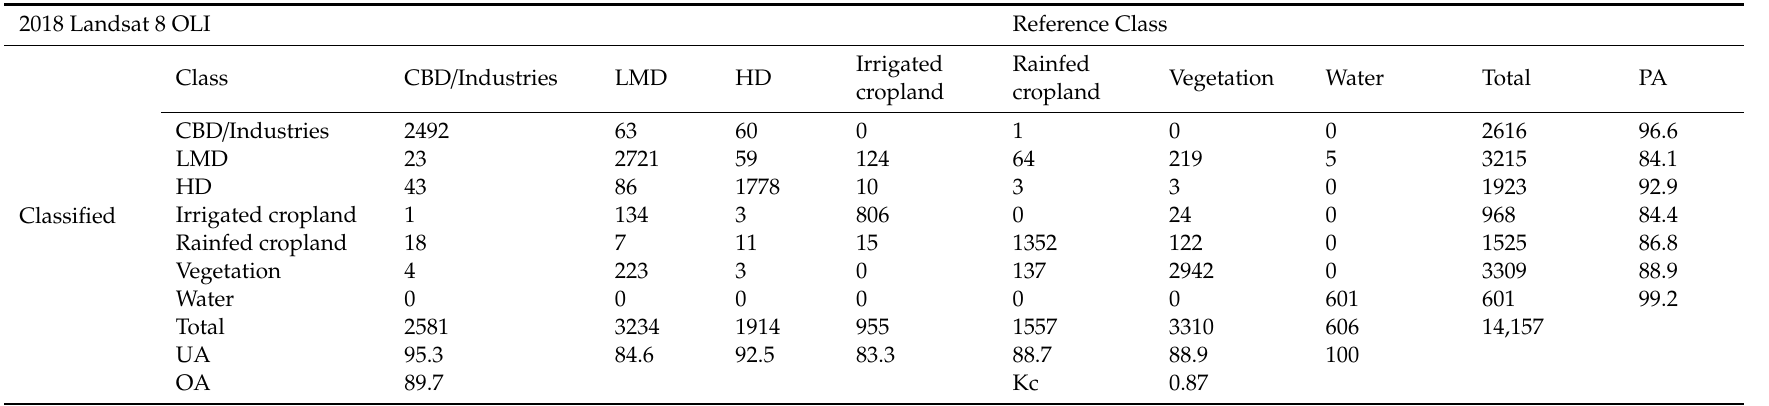
Table A2. Confusion matrix and associated classification accuracies produced from Landsat 8 OLI (2018). The accuracies include kappa (Kc), overall accuracy (OA), producer’s accuracy (PA) and user’s accuracy